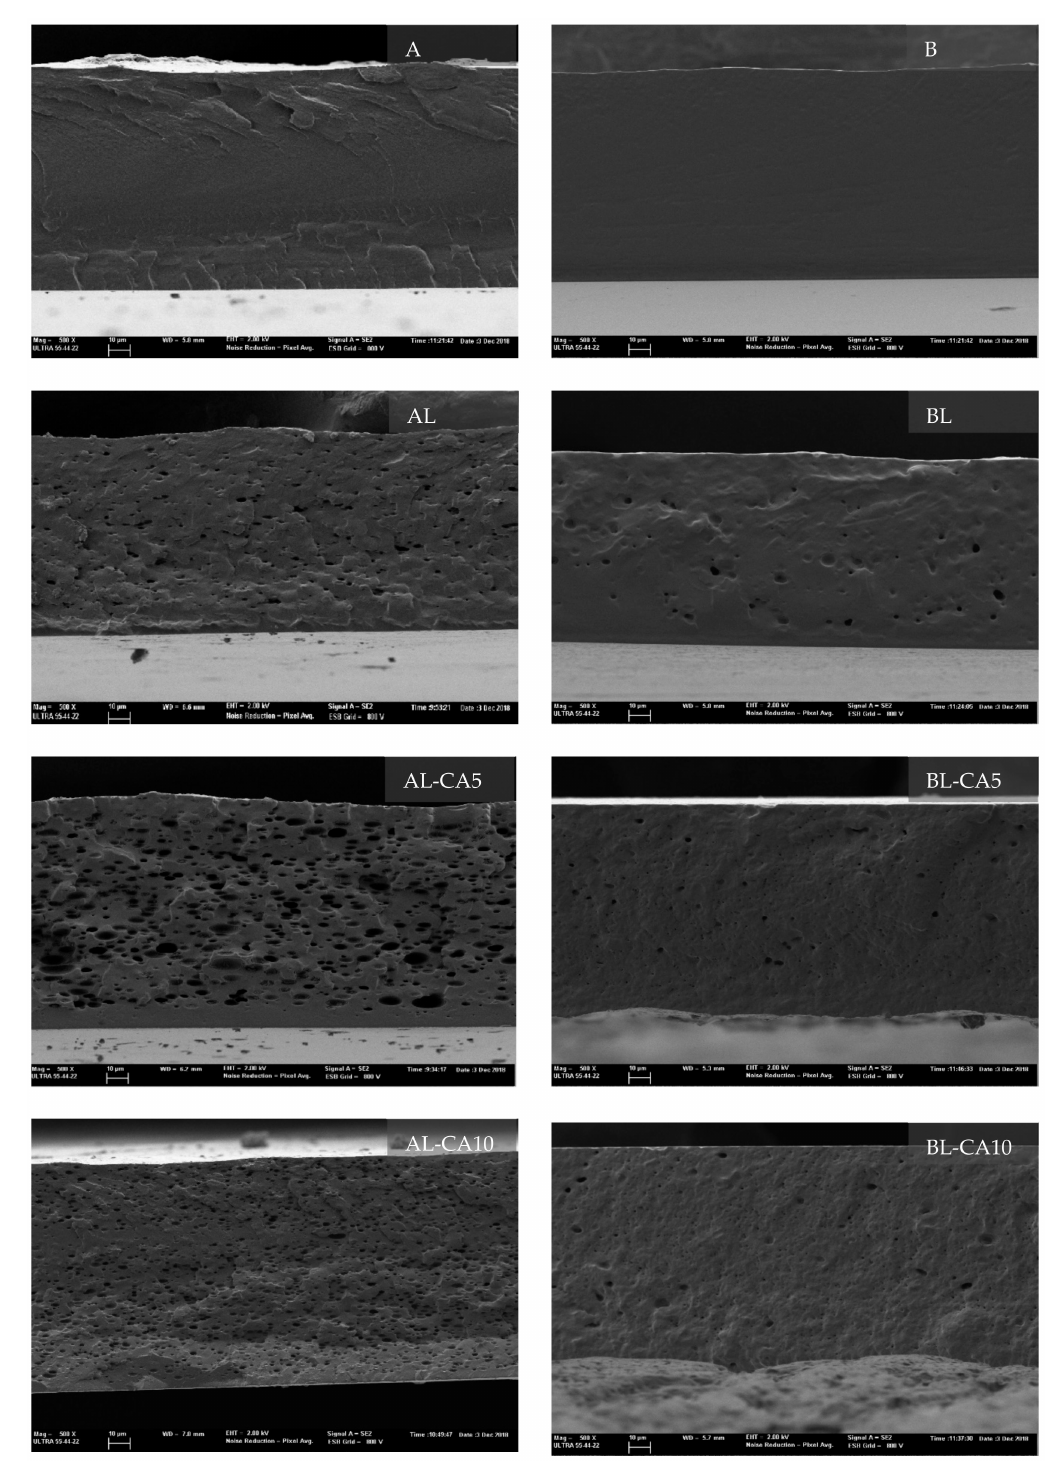
Figure 1. Field Emission Scanning Electron Microscope (FESEM) micrographs of the cross-section of the poly (vinyl) alcohol (PVA) A and B films with lecithin liposomes (L) and carvacrol loaded liposomes (L-CA) (5 or 10 g / 100 g PVA) (magnification: 500X; bar: 10 µ